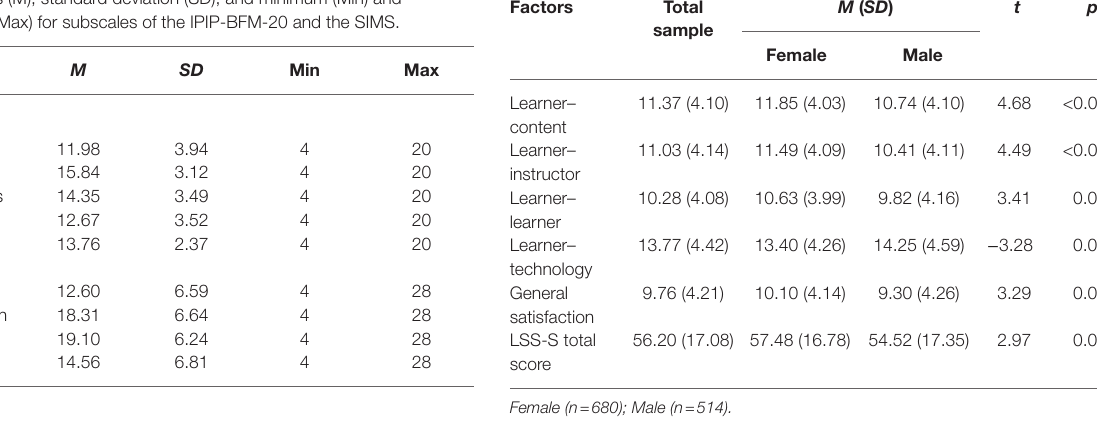
TABLE 6 | Value of the t-test for independent samples and probability (bilateral) for total sample and by gender.